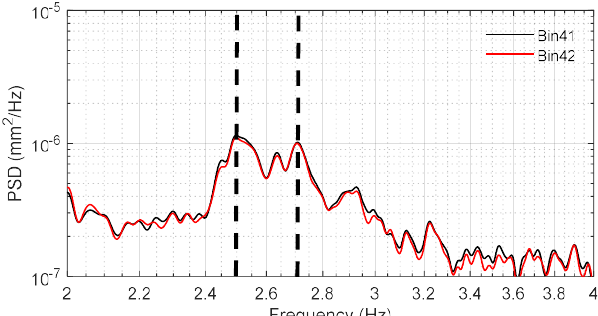
Figure 13. The PSD calculated by the Welch method for the signals recorded from Rbin41 and Rbin42. The dashed lines correspond, from left to right, to the frequencies of 2.49 and 2.71